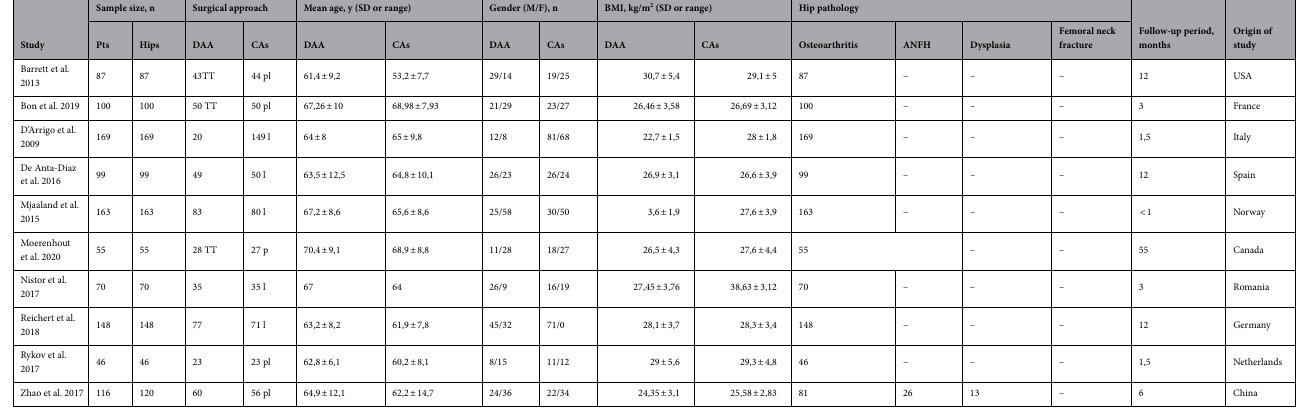
Table 1. Main characteristics of RCTs included in network meta-analysis. DAA direct anterior approach, TT traction table, CAs conventional approaches, pl posterolateral approach, p posterior approach, l lateral approach, Pts patients, ANFH aseptic necrosis of the femoral head.